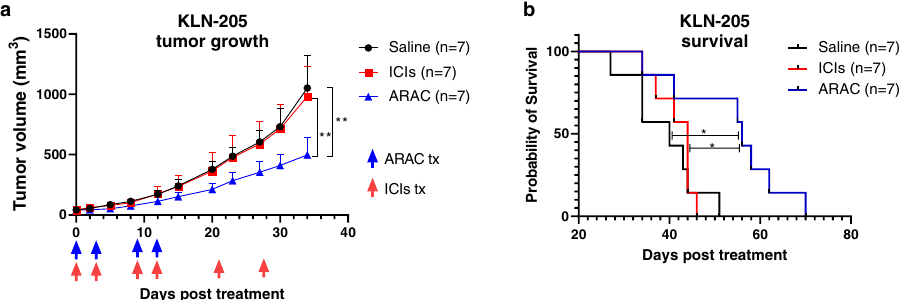
Fig. 7 ARAC reduces tumor growth and prolongs survival of mice bearing KLN-205 murine lung tumors. a DBA/2 mice were injected with 500,000 KLN-205 cells in 100 μ L PBS on the right fl ank. 13 days post inoculation, mice were grouped ( n = 7) and treated with saline, ICIs (PD-1 and CTLA-4 antibodies – i.p. 200 μ g/dose and 100 μ g/dose respectively – for 6 doses), or ARAC (i.v. 50 mg/kg for 4 doses). a KLN-205 tumor growth; blue arrows specify ARAC dosing days, red arrows specify ICI dosing days. Data presented as mean + SEM; ** P = 0.0011 for ARAC vs. saline, ** P = 0.0041 for